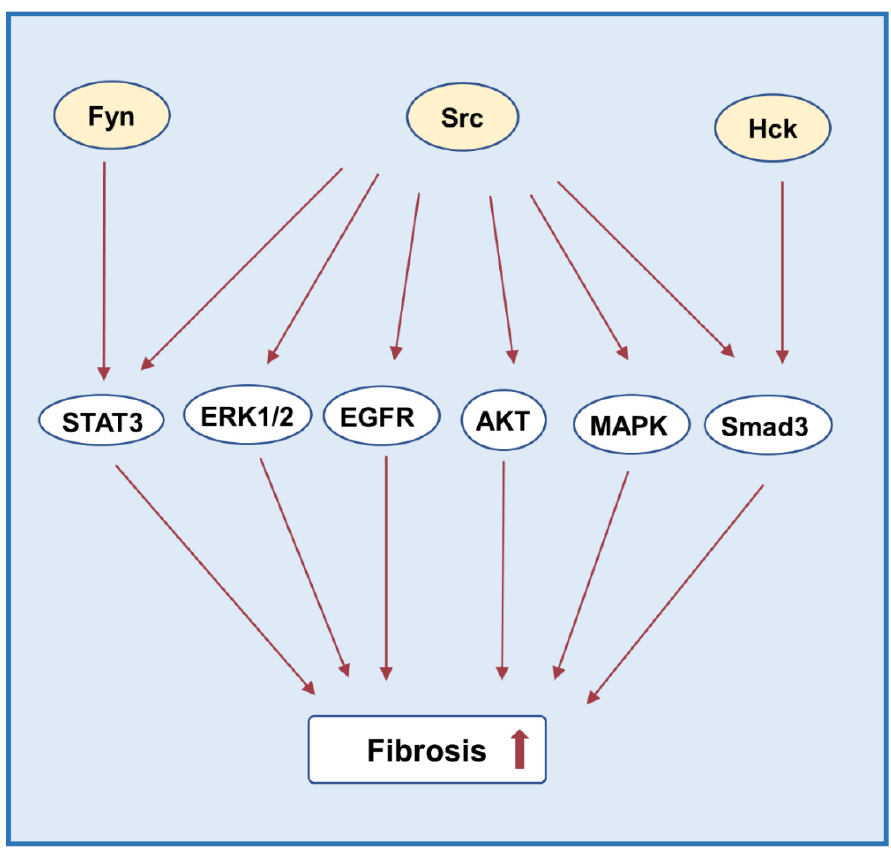
Figure 6. Src family kinases and fibrosis. Src activation results in phosphorylation of signal proteins STAT3, AKT, MAPK, and EGFR. Src also promotes the activation of Smad3 and ERK1/2. Fyn and Lck activate STAT3 and Smad3, respectively.